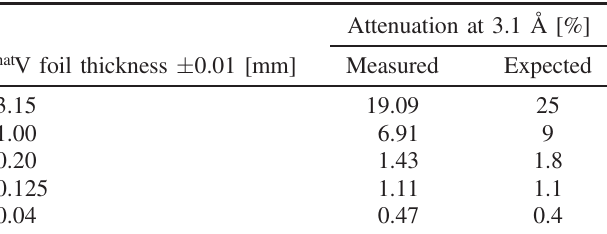
TABLE III. Measured and expected neutron attenuation in nat V at V20.